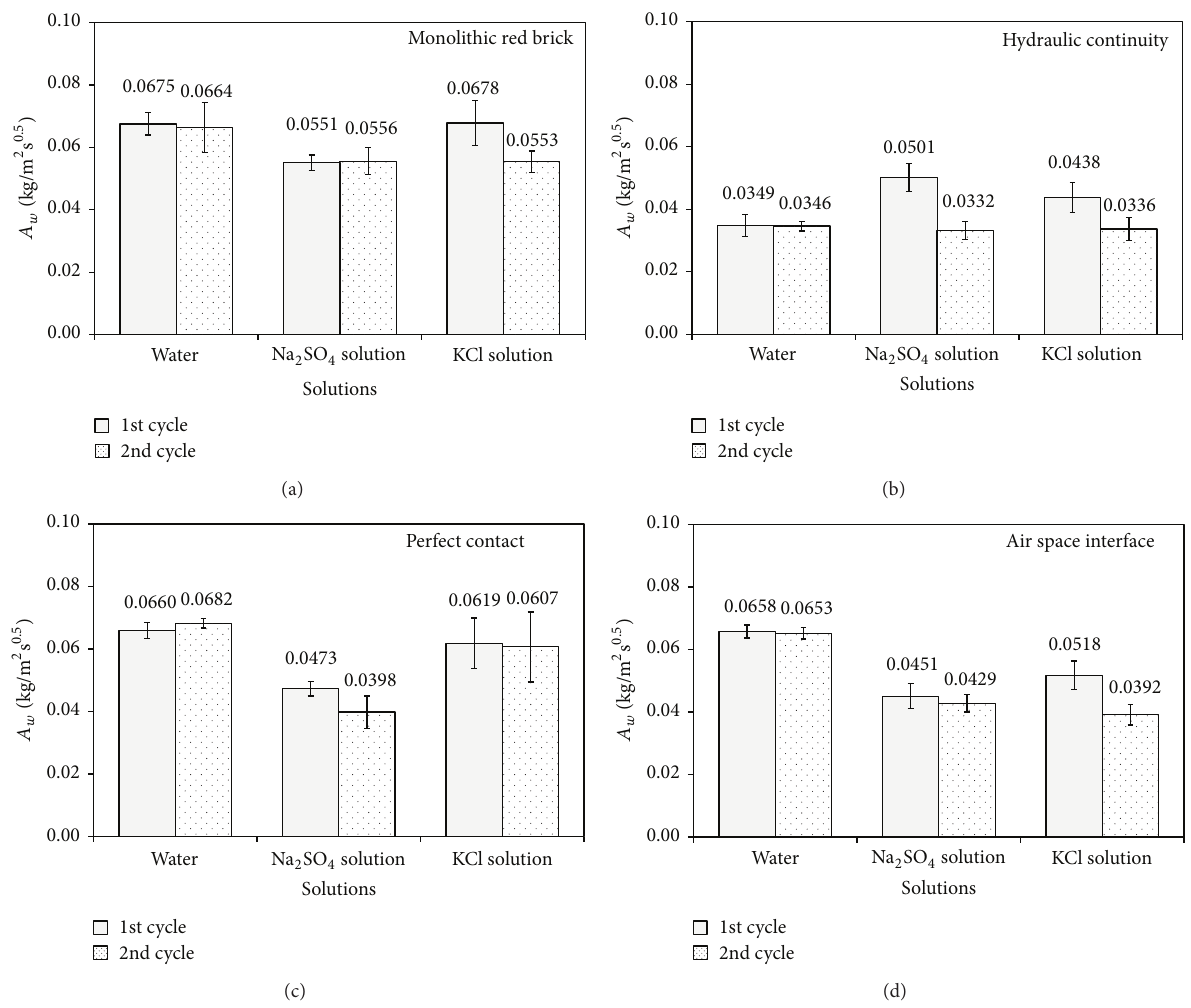
Figure 5: Water absorption coefficient of red brick samples after 1 and 2 cycles, with pure water and saturated solutions of KCl and Na 2 SO 4 , for (a) monolithic specimens, (b) hydraulic continuity interface, (c) perfect contact interface, and (d) air space interface.